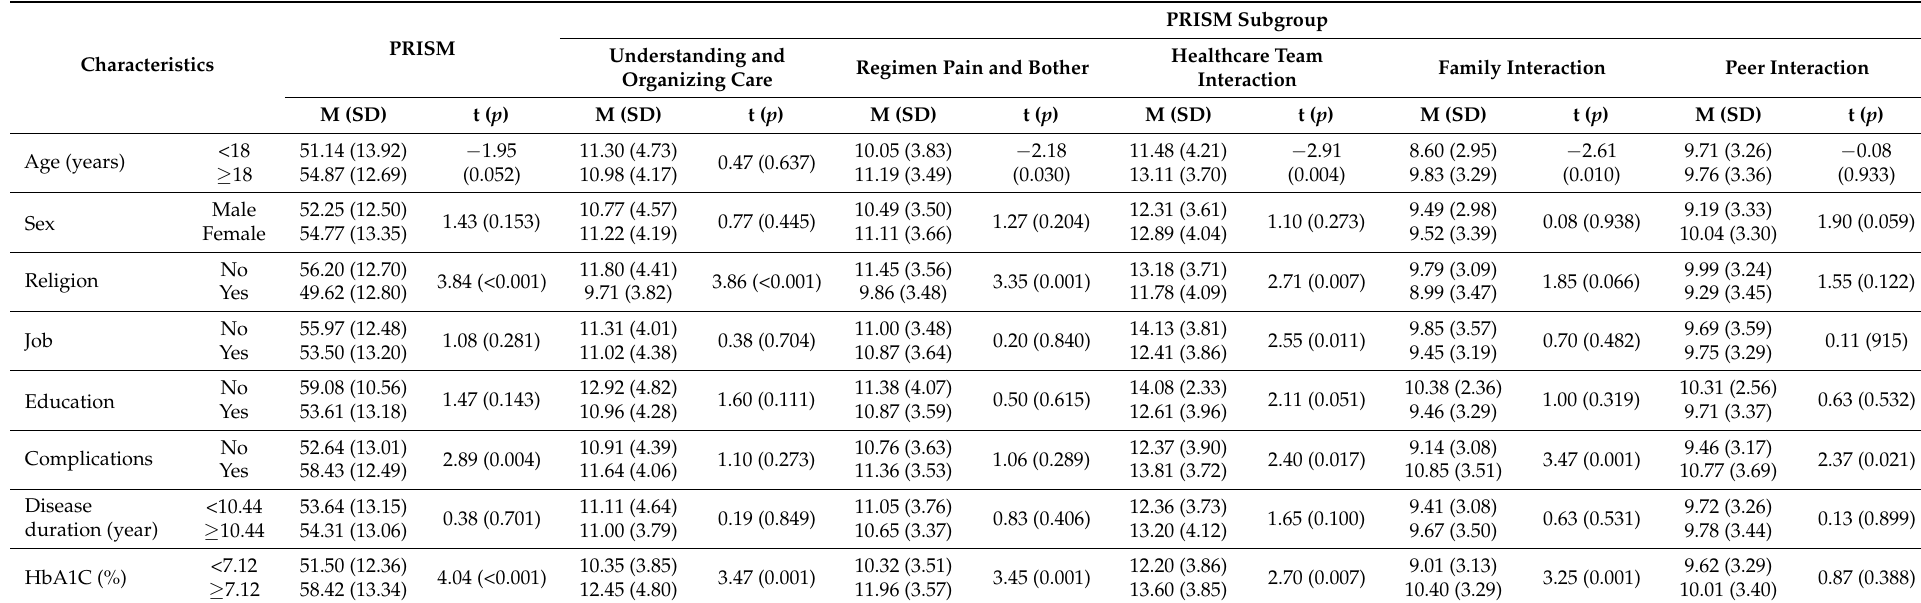
Table 3. PRISM scores by participants’ characteristics ( n =